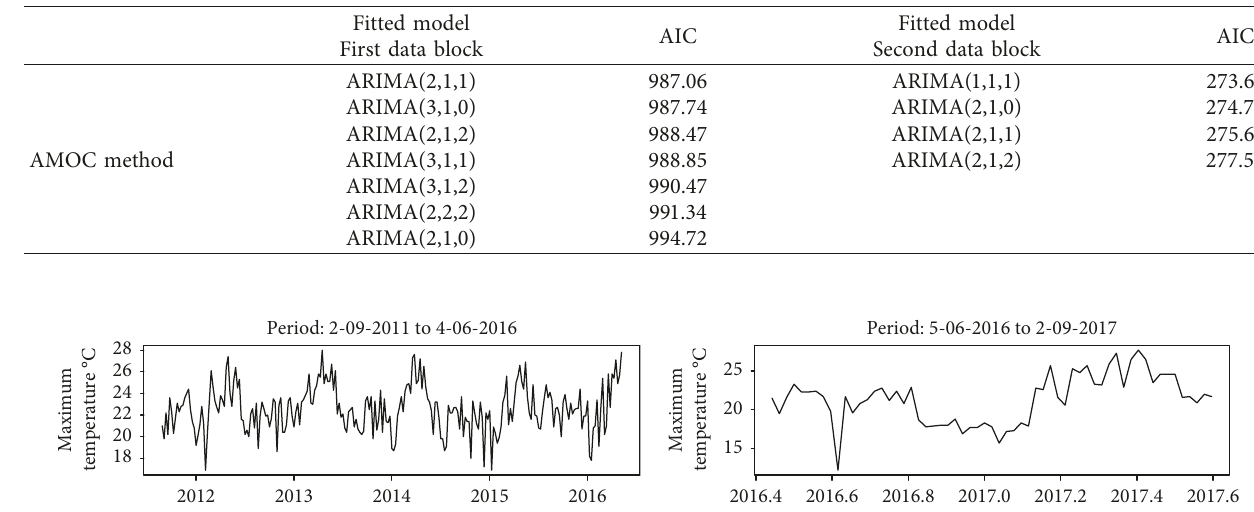
Table 9: Models fitted after applying the AMOC method.